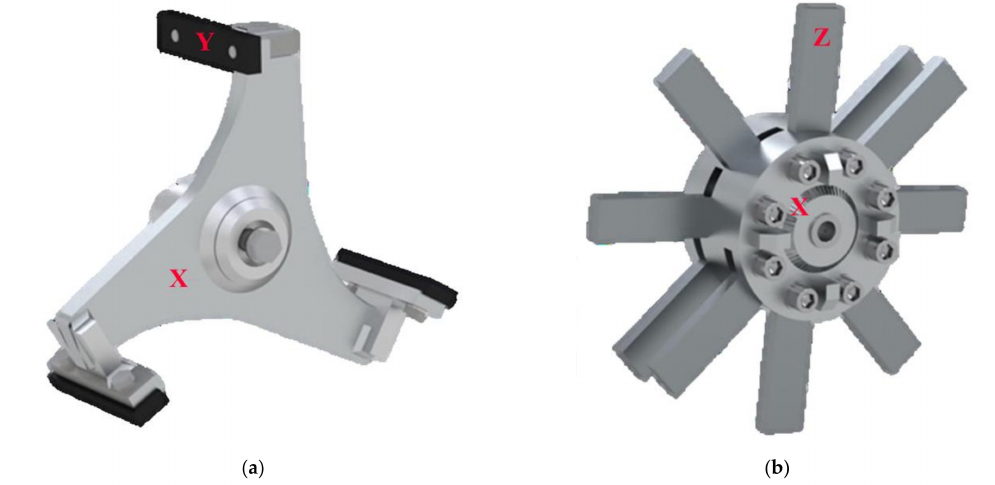
Figure 2. ( a ) Hammer Crusher Rotor: (X) rotor, (Y) hammer. ( b ) Knife Crusher Rotor: (X) rotor, (Z)